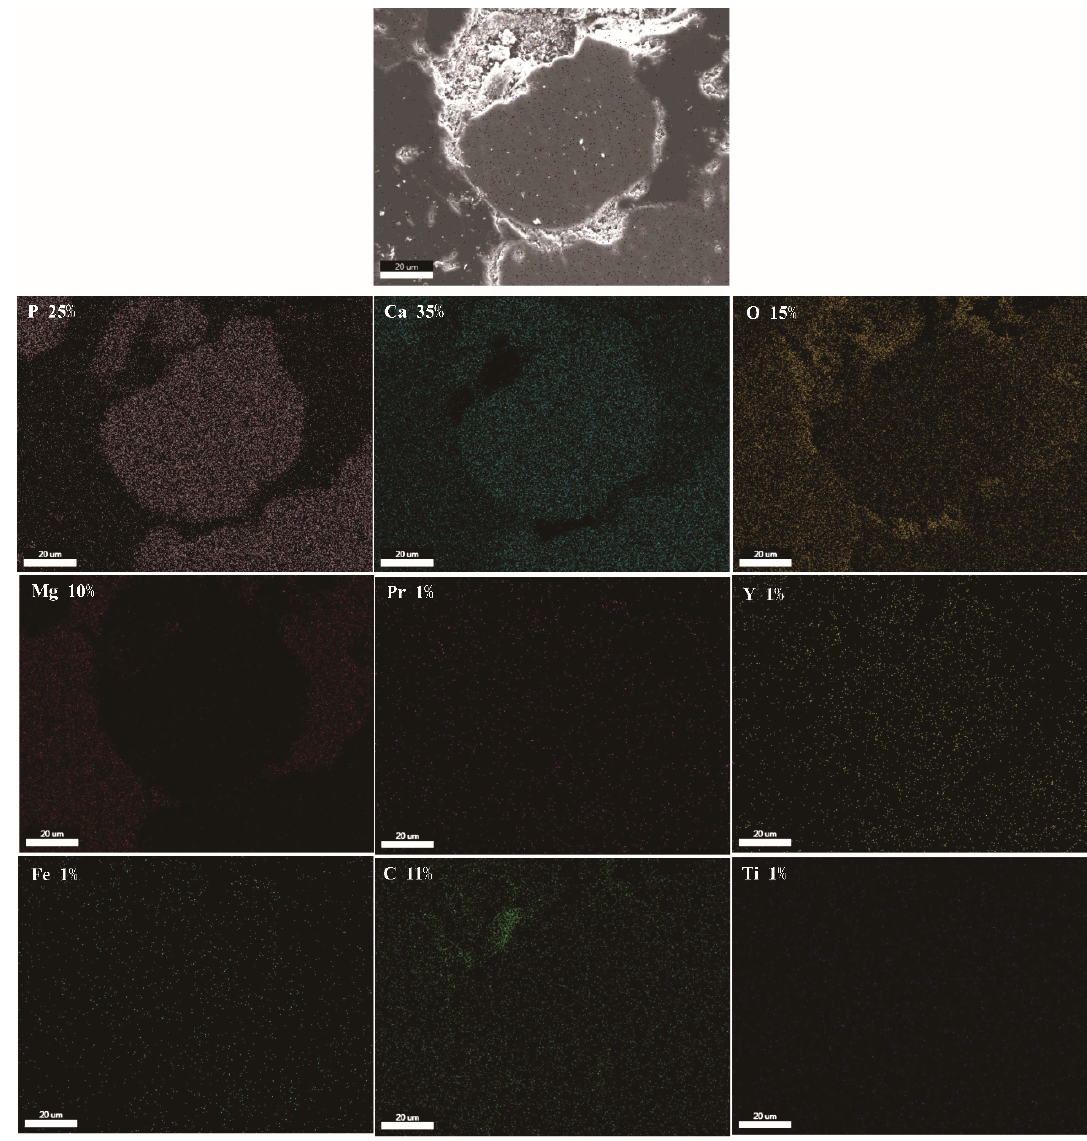
Figure 5. The backscatter electron (BSE) images of a sample from phosphorite ores using focused ion beam ‐ scanning electron microscope (FIB ‐ SEM) analyses.